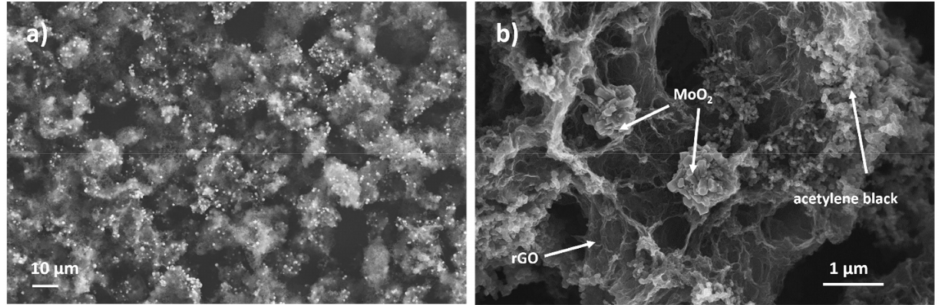
Figure 6. FESEM images of the electrode material containing rGO-MoO 2 - vitC , acetylene black, and Nafion after 5000